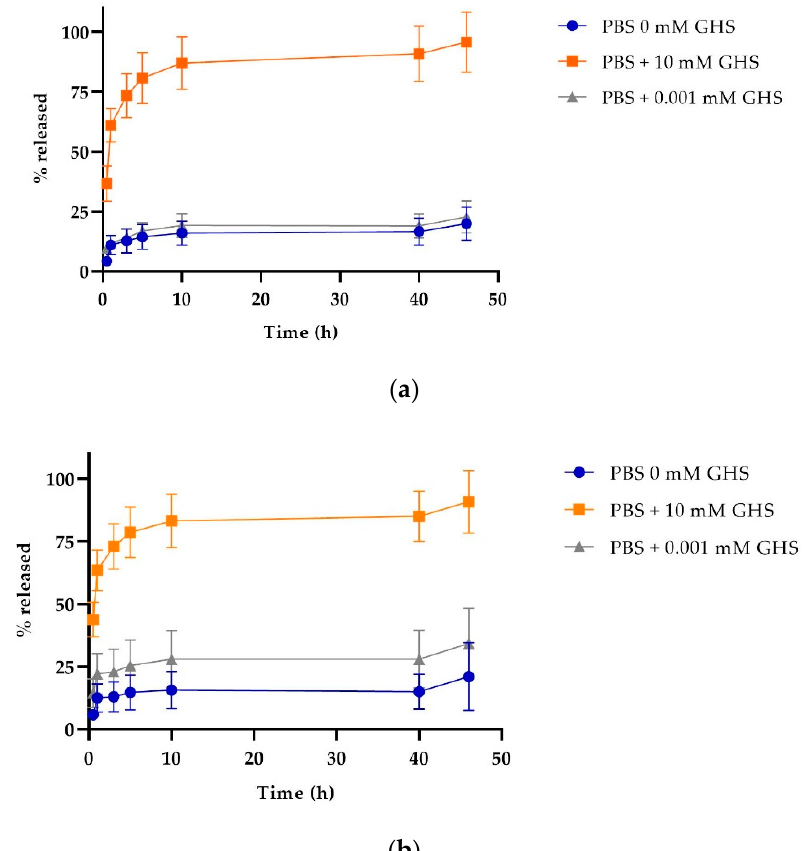
Figure 7. Cytochrome c release profile of nanoparticles under reducing (intracellular) and non-reducing (extracellular) conditions. Cyt c release profile for ( a ) NP-253, top and ( b ) NP-354, bottom. The data are the averages of three release experiments, and the error bars are the calculated SD.